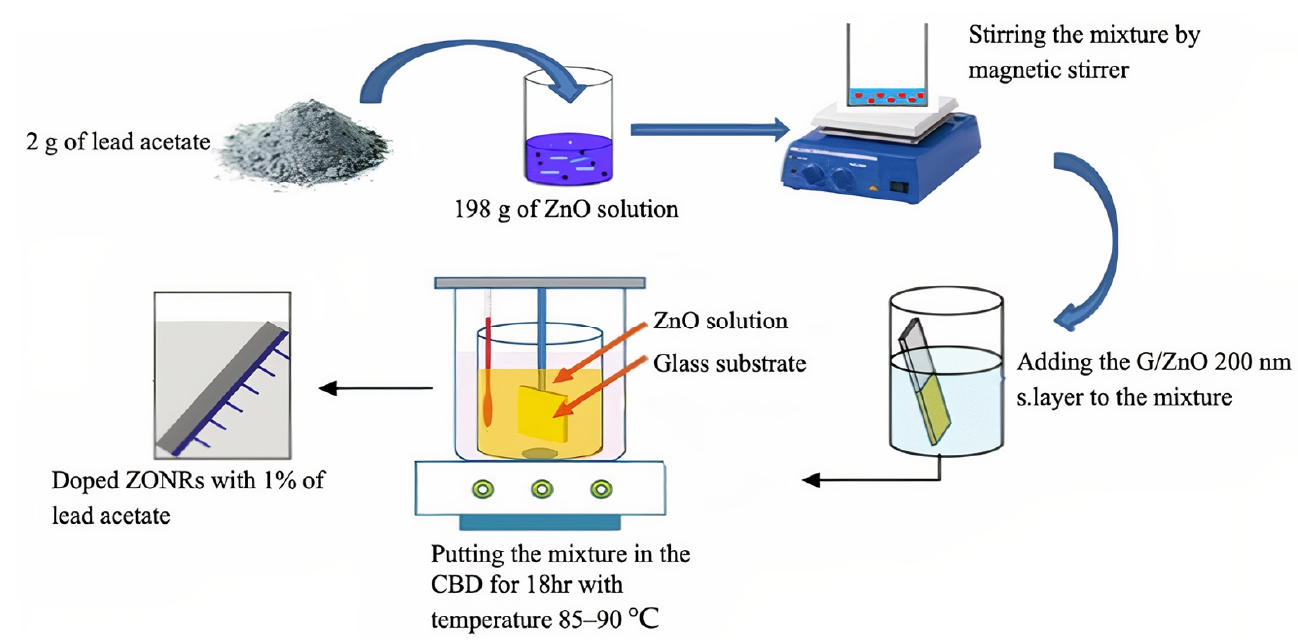
Figure 3. Various stages of sample preparation via CBD.